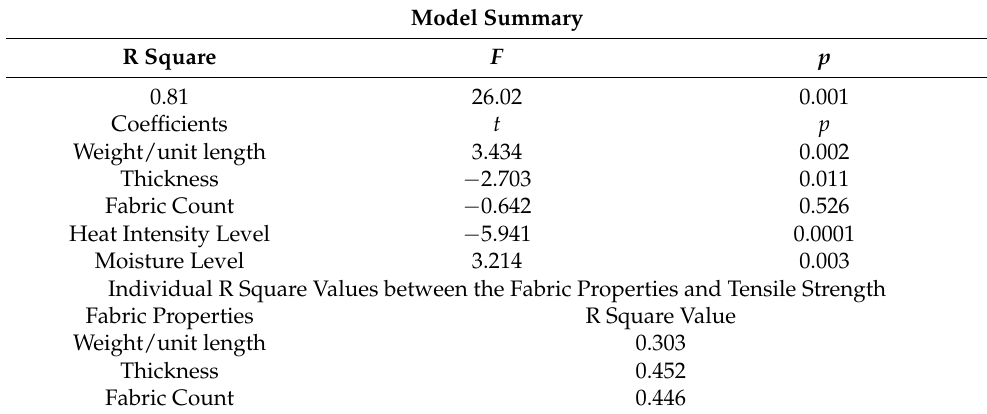
Table 7. Statistical analysis of multi-layered fabric system in presence of moisture in the thermal liner.